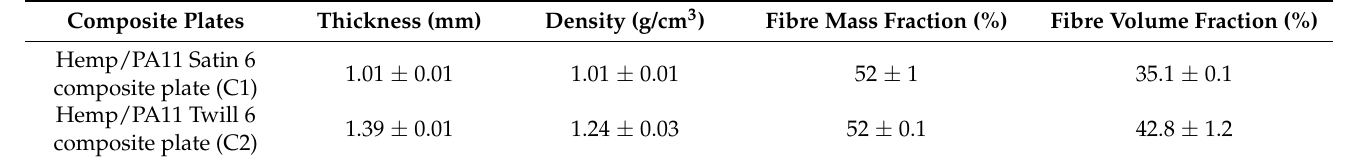
Table 4. The physical properties of the two composites.